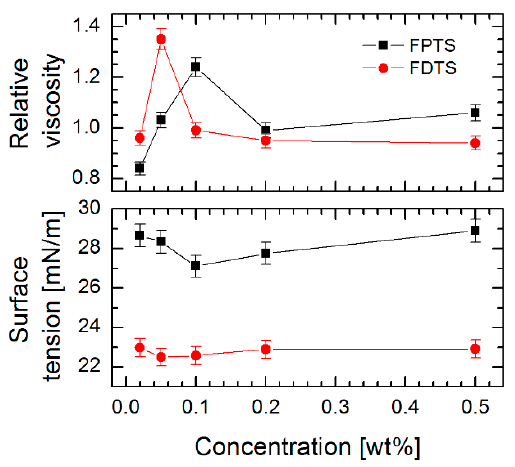
Figure 1. Influence of concentration of (3, 3, 3-trifluoropropyl) trichlorosilane (FPTS) and 1H, 1H, 2H, 2H-perfluorodecyltrichlorosilane (FDTS) compound on viscosity and surface tension of solutions.